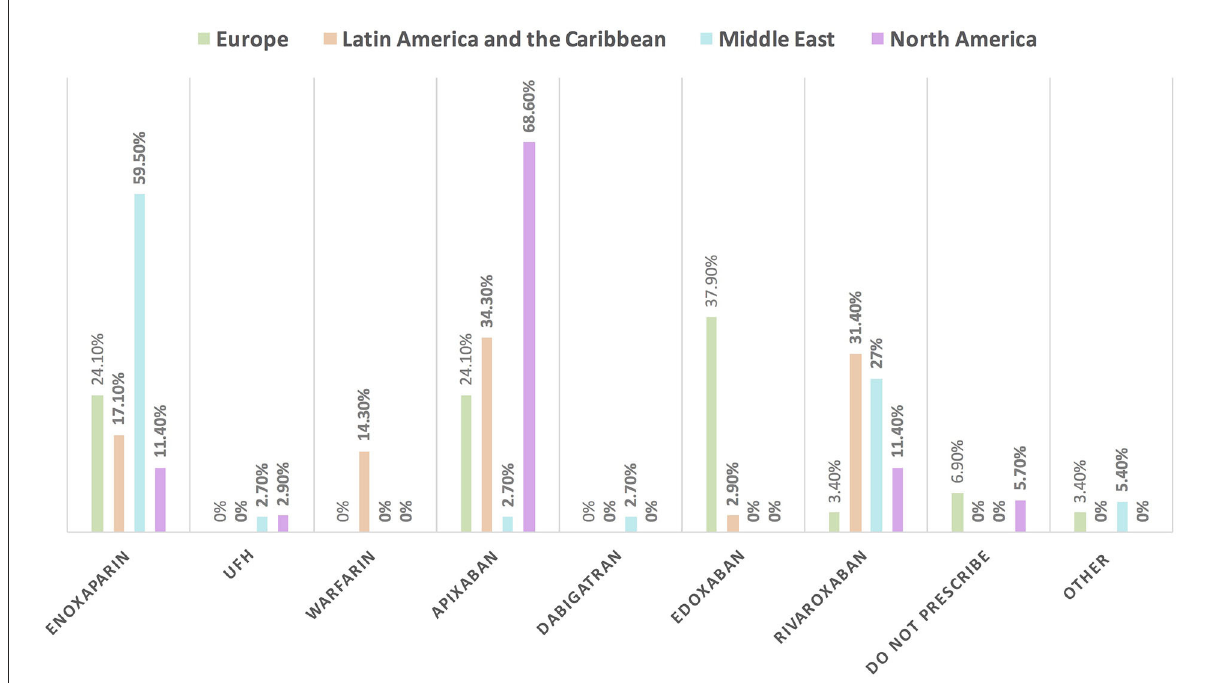
FIGURE11 The most common prescribed anticoagulant for the management of VTE in patients with cancer without COVID-19 infection in different continents. There was obvious regional variation in the selection of anticoagulants for the management of VTE in patients with cancer. The most commonly prescribed anticoagulant is enoxaparin in the Middle East; apixaban in North America, Latin America and the Caribbean; and edoxaban in Europe. UFH, unfractionated heparin; VTE, venous thromboembolic